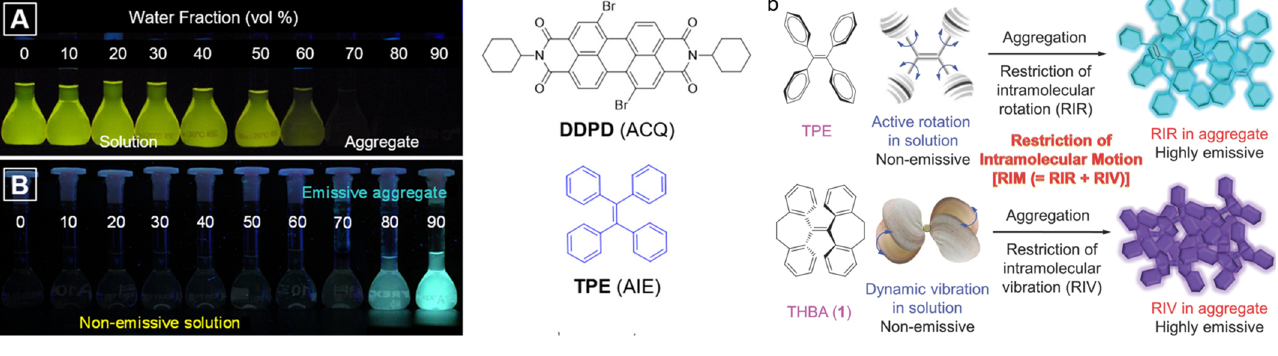
Figure 1. ( a ) Photographs of ACQ and AIE molecules in the mixture of water/THF with different water fractions under 365 nm of UV light irradiation (reproduced with the permission from ref. [40]. Copyright 2018, American Chemical Society); ( b ) schematic illustration of RIM mechanism, including restriction of intramolecular rotation and restriction of intramolecular vibration. (Reproduced with the permission from ref. [39]. Copyright 2014, WILEY-VCH Verlag GmbH & Co. KGaA, Weinheim).